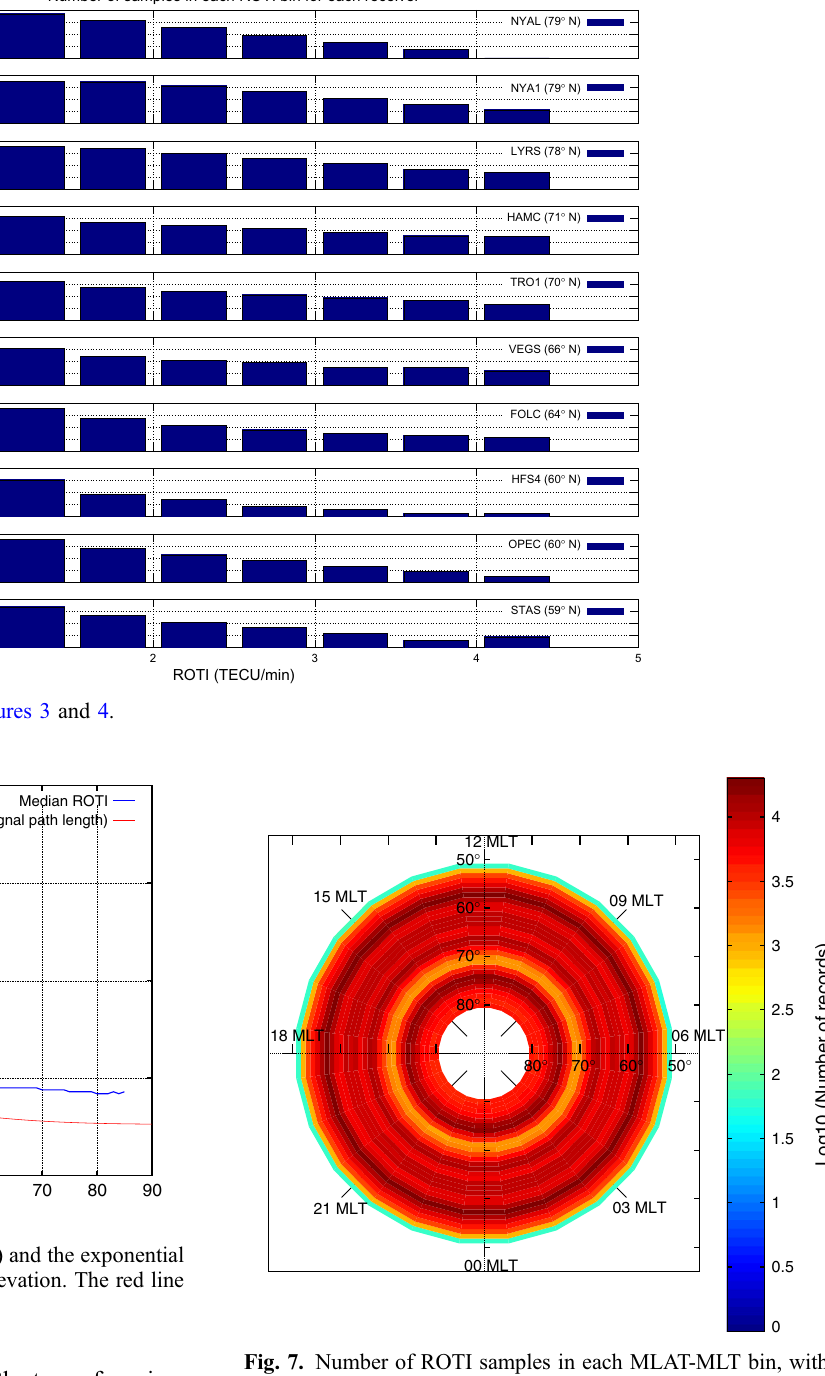
Fig. 7. Number of ROTI samples in each MLAT-MLT bin, with an elevation cutoff of 30 (cid:2)